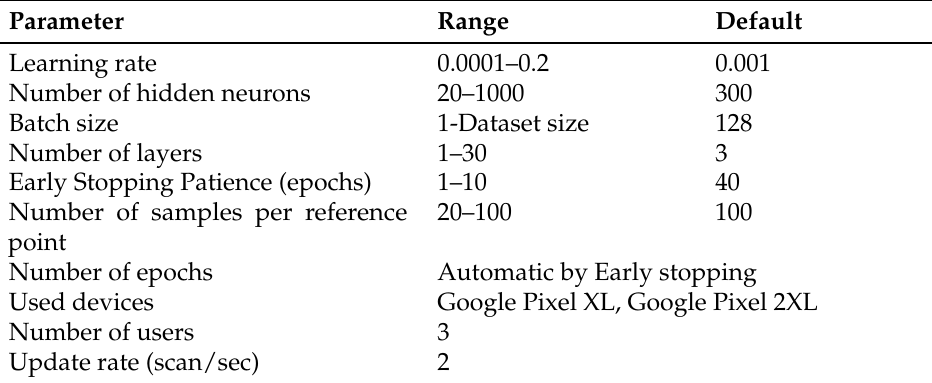
Table 3. Default parameters values used in the evaluation.